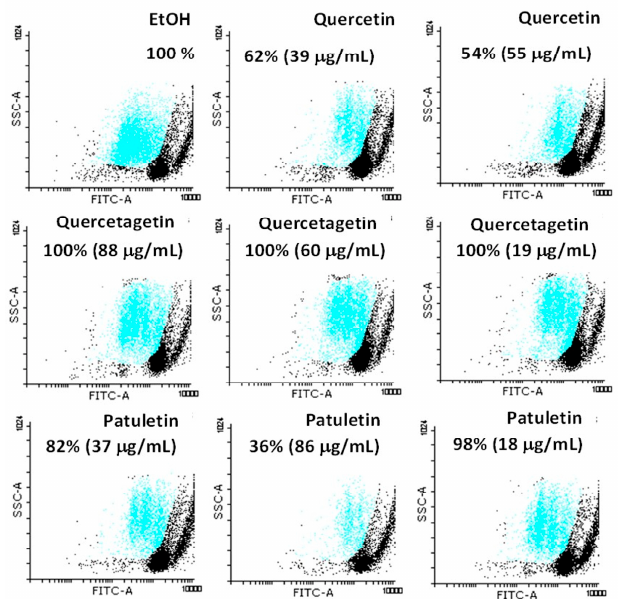
Figure 12. Evaluation of the anti-proliferative effect of quercetin, quercetagetin and patuletin in lymphocytes. The compounds showed no evidence of any anti-proliferative effect on normal